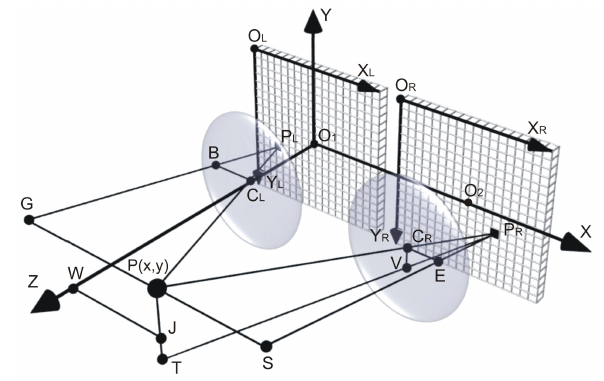
Figure 3: 3D-view of geometric scheme of the stereoscopic system. global coordinates that should be defined. The optical scheme of the considered stereoscopic system is presented in Figures 1a and 2a. The 3D orthogonal system of XYZ coordinates was applied for this scheme, its initial point O coinciding with the left camera matrix center, and axis Z being perpendicular to plane YOX containing CCD ma- trixes of the left and the right video cameras. The left and the right video cameras are shown in the scheme (Figure 1a), their optical axes are parallel and they pass through points O , O correspondingly, and are also 1 2 perpendicular to the plane of the CCD matrix location. Let the distance O between the axes of two cameras be 1 O 2